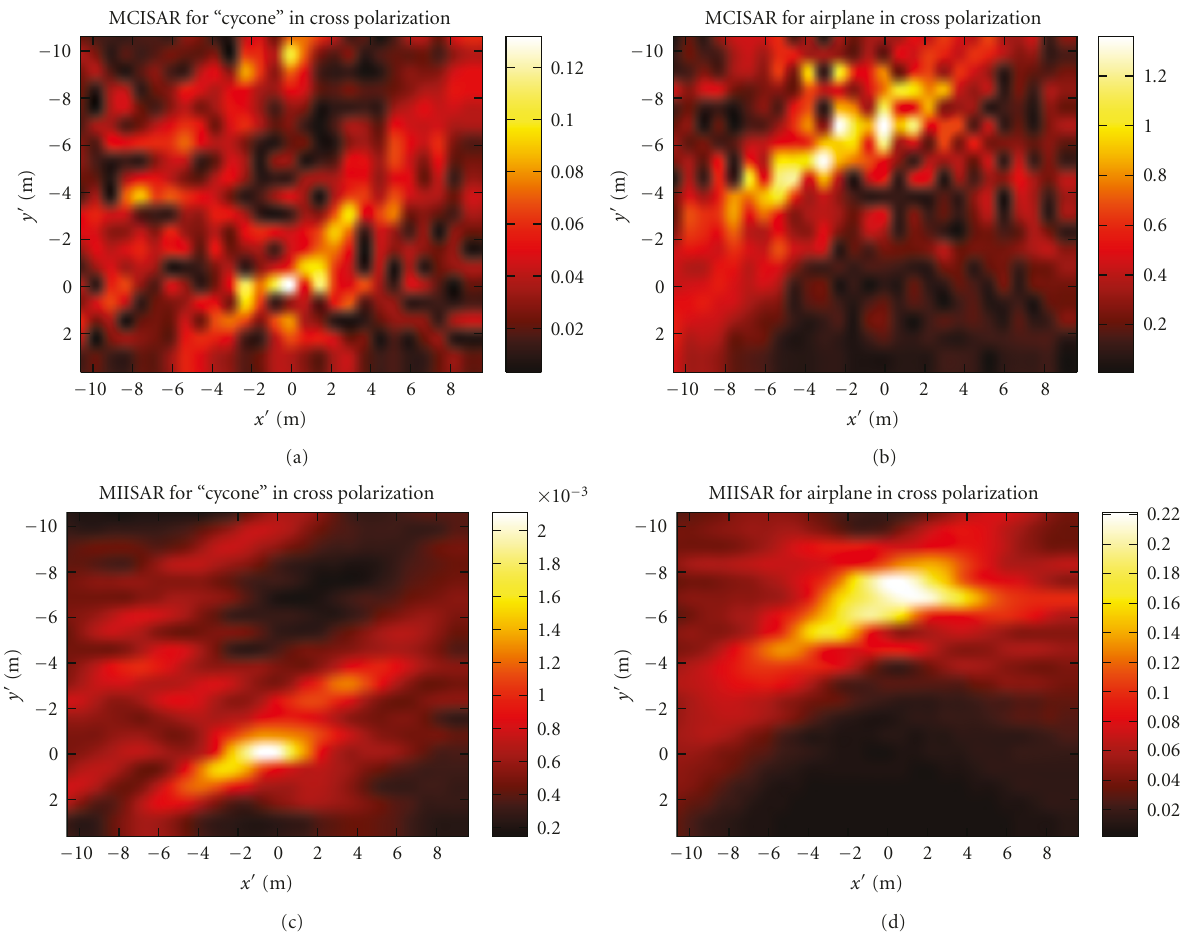
Figure 15: MCISAR results in cross polarization of the “cycone” (a) and airplane (b) and MIISAR results in cross polarization of the “cycone” (c) and airplane (d).